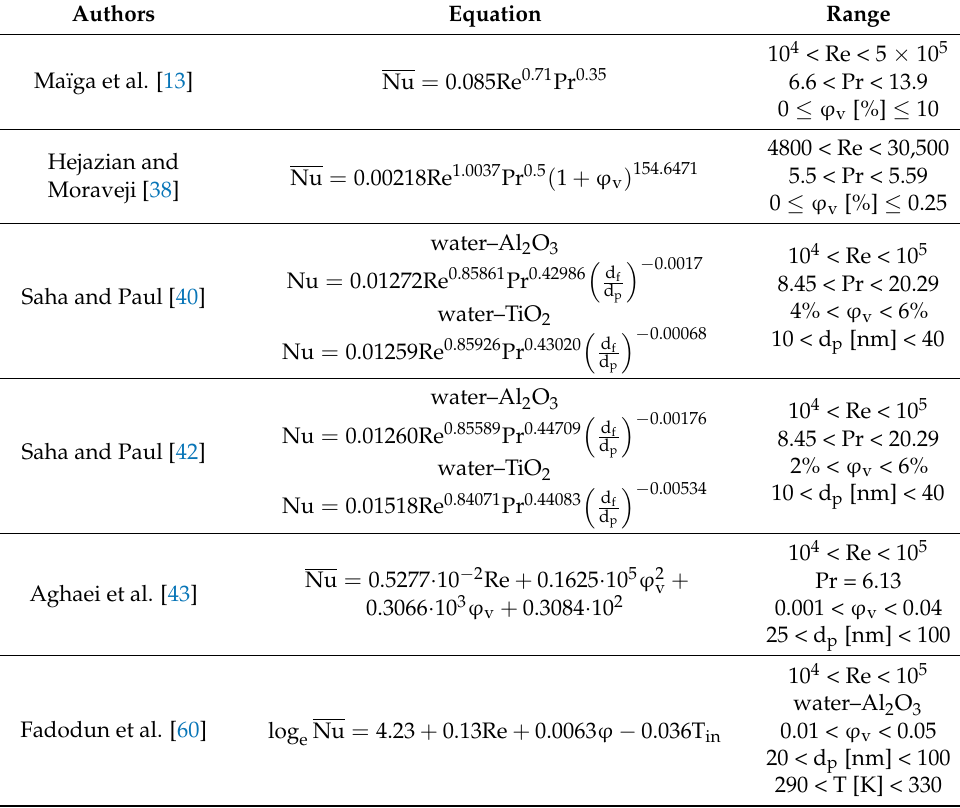
Table 4. Correlation equations for turbulent flow of